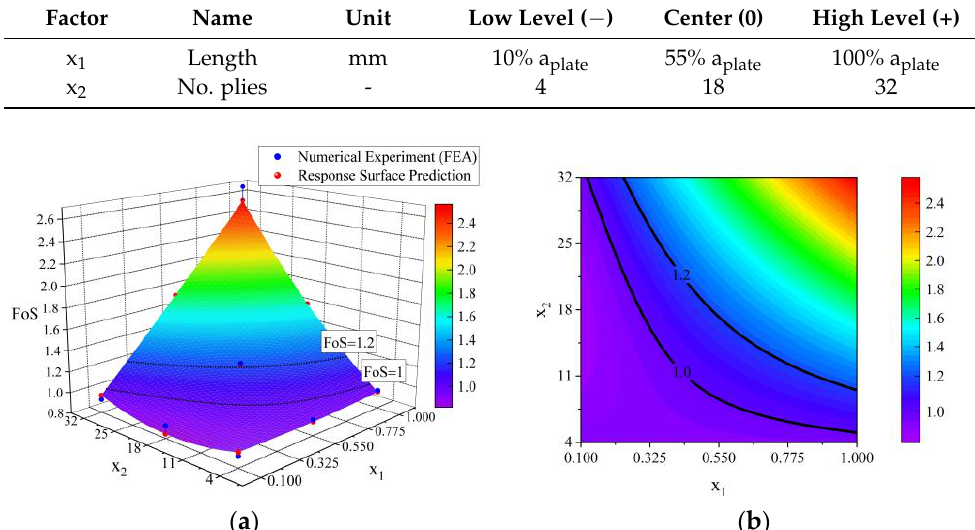
Figure 11. Response surface (buckling FoS) in a 3D design space ( a ) and its isolines projected to a 2D contour ( b ).